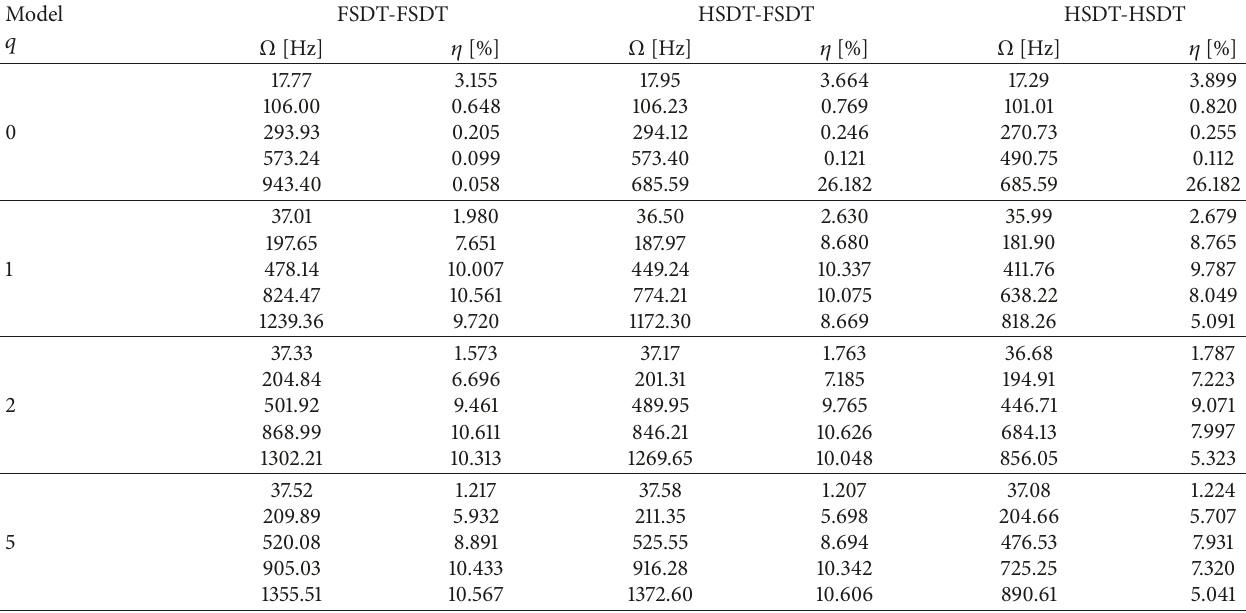
Table 17: Frequencies Ω and loss factors 𝜂 . 𝑤 max GNP = 5 % . Core ( 𝐶3 – 𝐶1 ). Mg, 𝑝 = 1 . Model